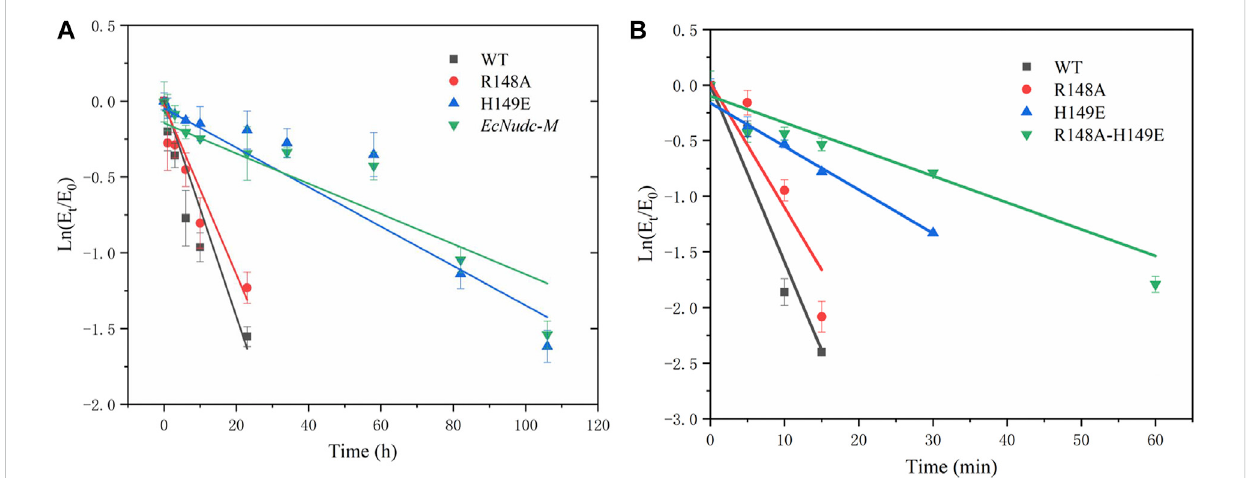
FIGURE 7 Thermal stability of wild type and mutants. (A) Thermal stability of wild type and mutants at 40 ° C. (B) Thermal stability of wild type and mutants at 50 ° C.